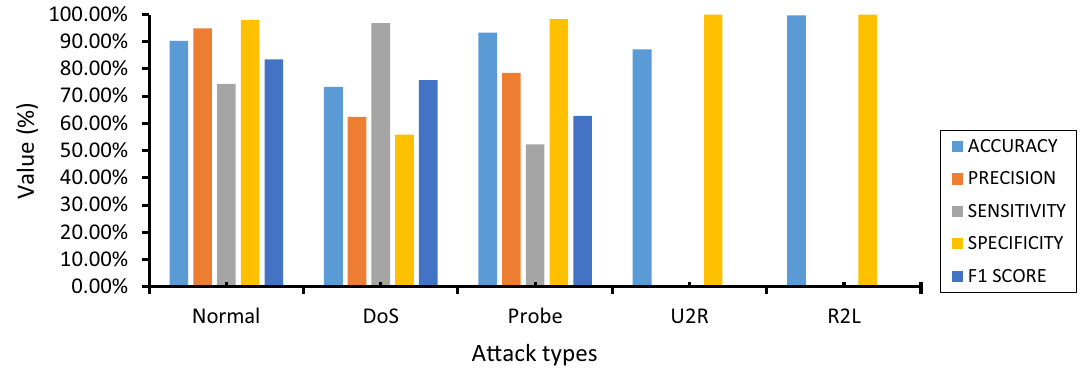
Fig. 3 Graphical representation of model performance on the attack types before feature